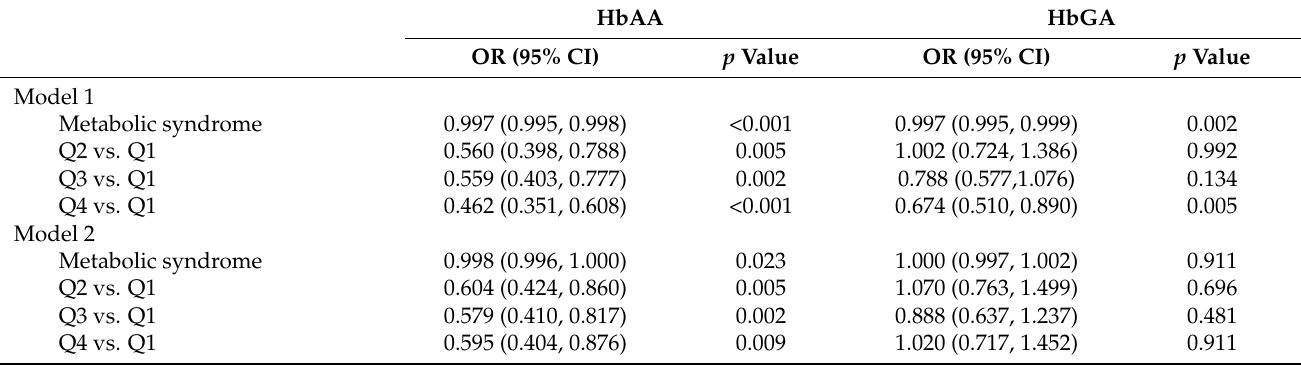
Model 1 = unadjusted. Model 2 = Model 1 + age, gender, race-ethnicity, serum AST, serum creati- nine, emphysema, angina/angina pectoris, smoking.